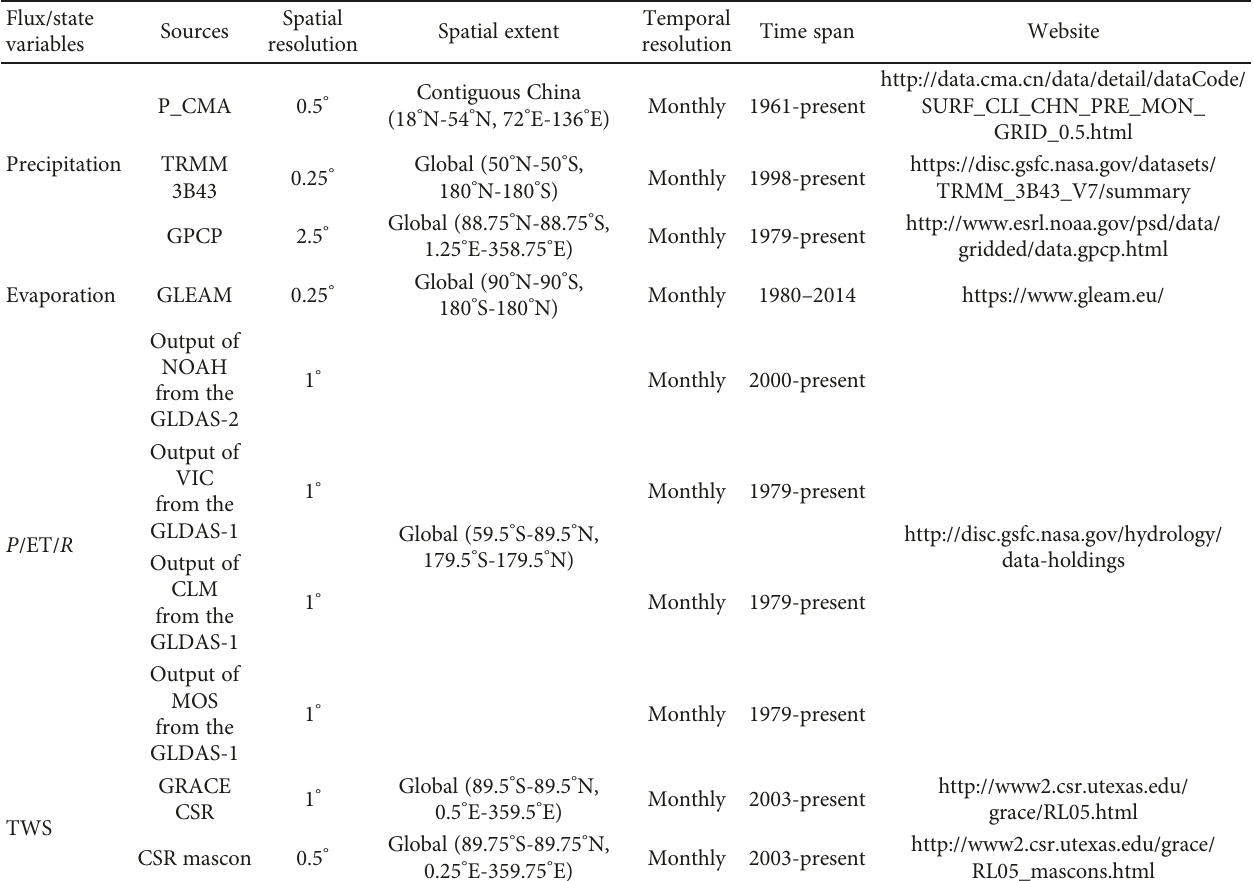
Table 1: Data sources used in this